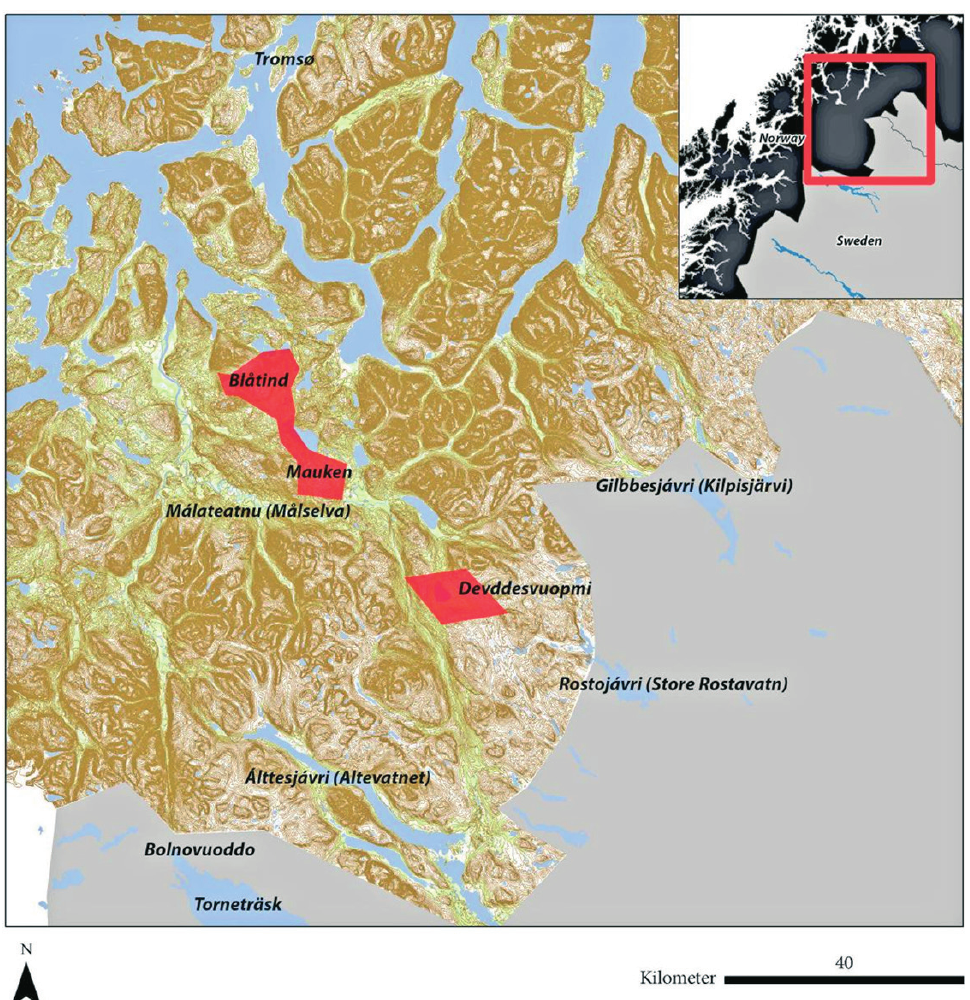
Fig. 1. Interior of Troms county (Inner Troms), areas of archaeological investigation. Illustration: Ingrid Sommerseth and Johan Eilertsen